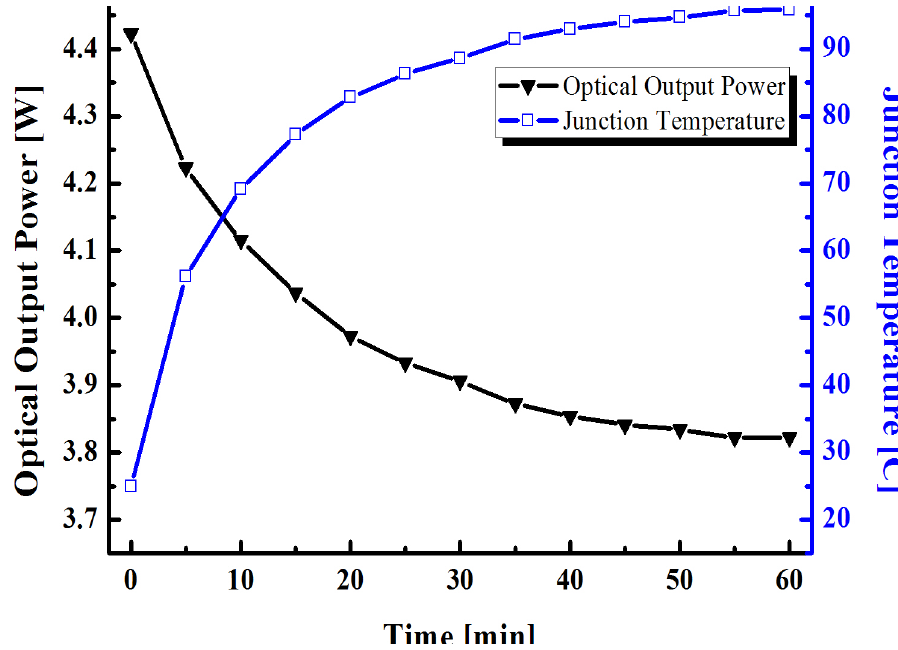
Figure 3. Blue laser diode light output and junction temperature characteristics over time.